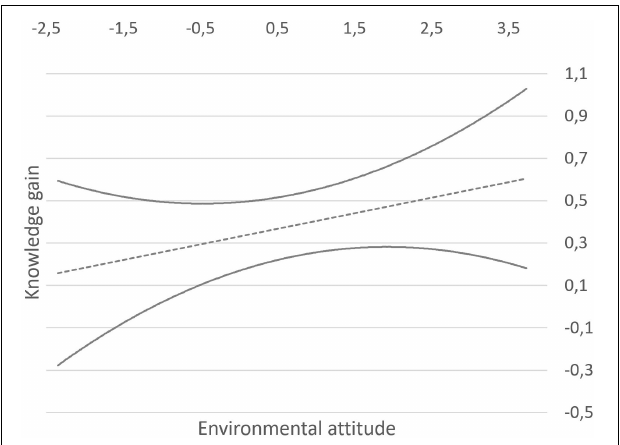
FIGURE 2 | Environmental knowledge gains after the Earthkeepers program regressed on environmental attitude. Their relationship is depicted in the dashed upward trend line. Bold lines show the 95% confidence interval. Both scales are based on a Rasch calibration, so the higher the score, the more knowledge students gained and the stronger the attitude